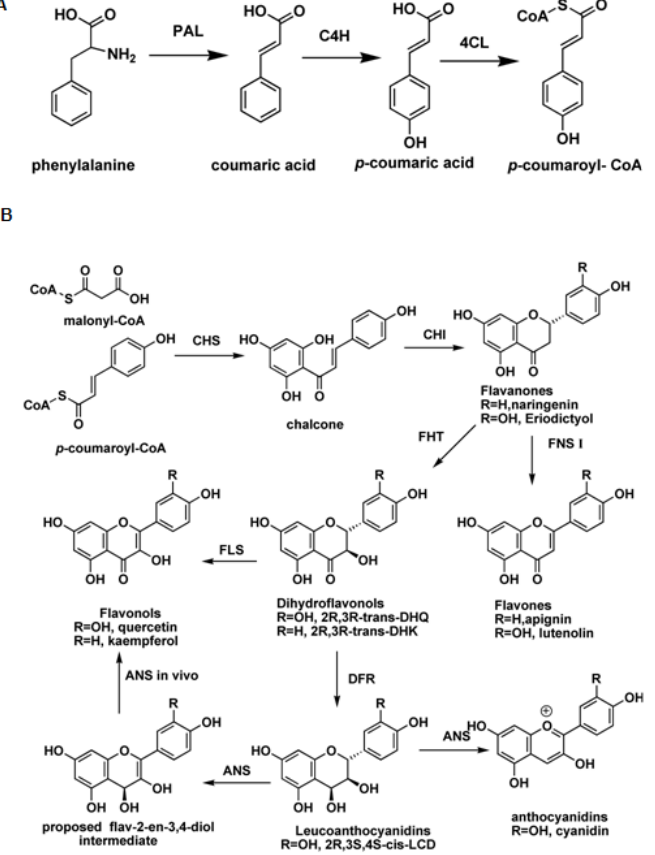
Figure 2. The biosynthesis pathway of flavonoids. ( A ) The biosynthesis of p -coumaroyl-CoA; ( B ) The biosynthesis of different kinds of flavonoids from p -coumaroyl-CoA and malonyl-CoA. PAL: Phenylalanine ammonia-lyase, C4H: Cinnamic acid 4-hydroxylation, 4CL: 4-Coumarate:Coenzyme A ligase, CHS: Chalcone synthase, CHI: Chalcone isomerase, FHT: Flavanone 3 β -hydroxylase, FNS Ι : Flavone synthase Ι